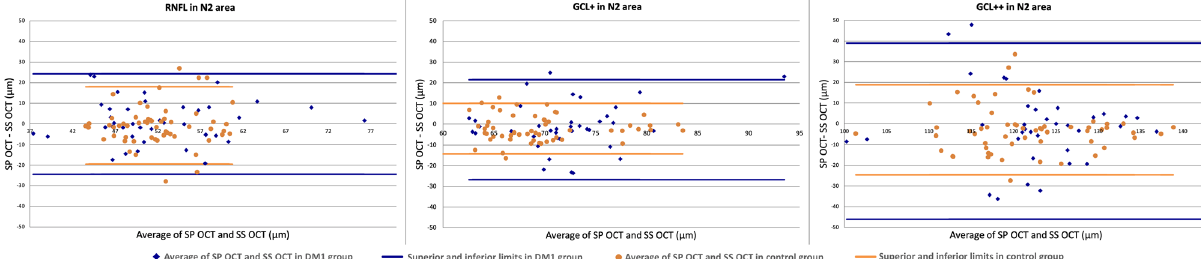
Figure 5. Blandt–Altman plots for the RNFL (from the ILM to the RNFL), the GCL+ (from the RNFL to the IPL) and the GCL++ (from the ILM to the IPL) average thickness between SD-OCT and SS-OCT in the nasal outer area N2. In each plot, corresponding layer is represented for the DM1 group in blue and for the control group in orange. RNFL Retinal nerve fiber layer, GCL Ganglion cell layer, ILM Inner limiting membrane, IPL